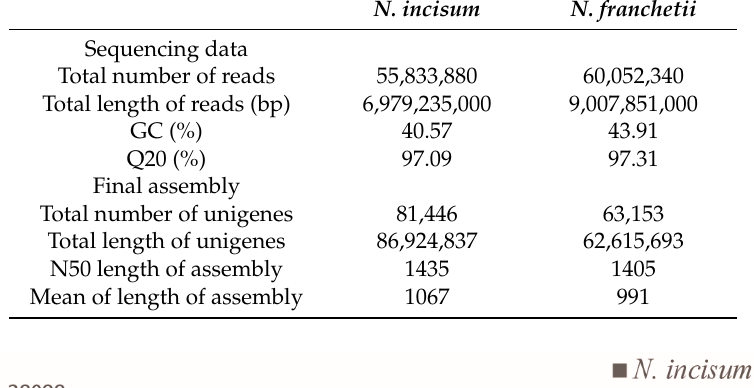
Table 1. Summary of transcriptome data for Notopterygium incisum and Notopterygium franchetii .